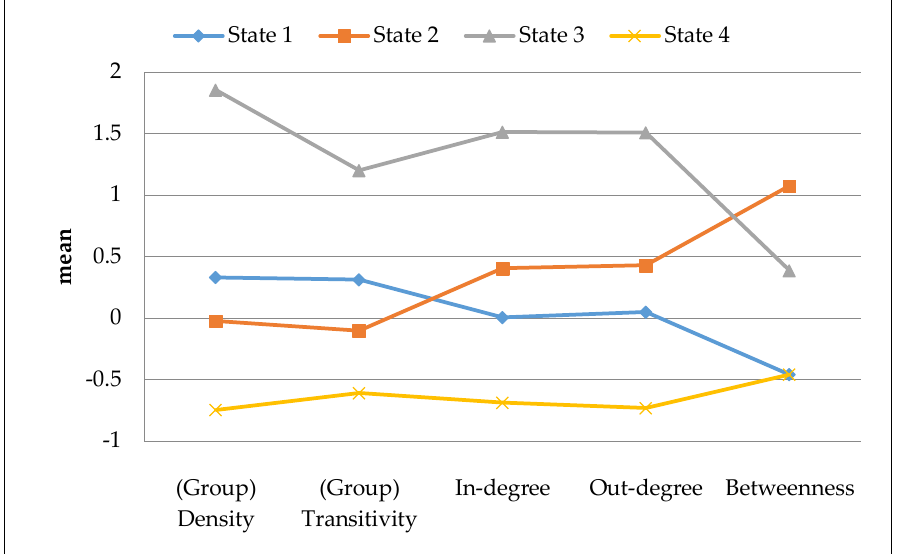
Figure 1. Distribution of the standardized network statistics. Note: X-axis represents social network statistic, Y-axis represents standardized mean value.